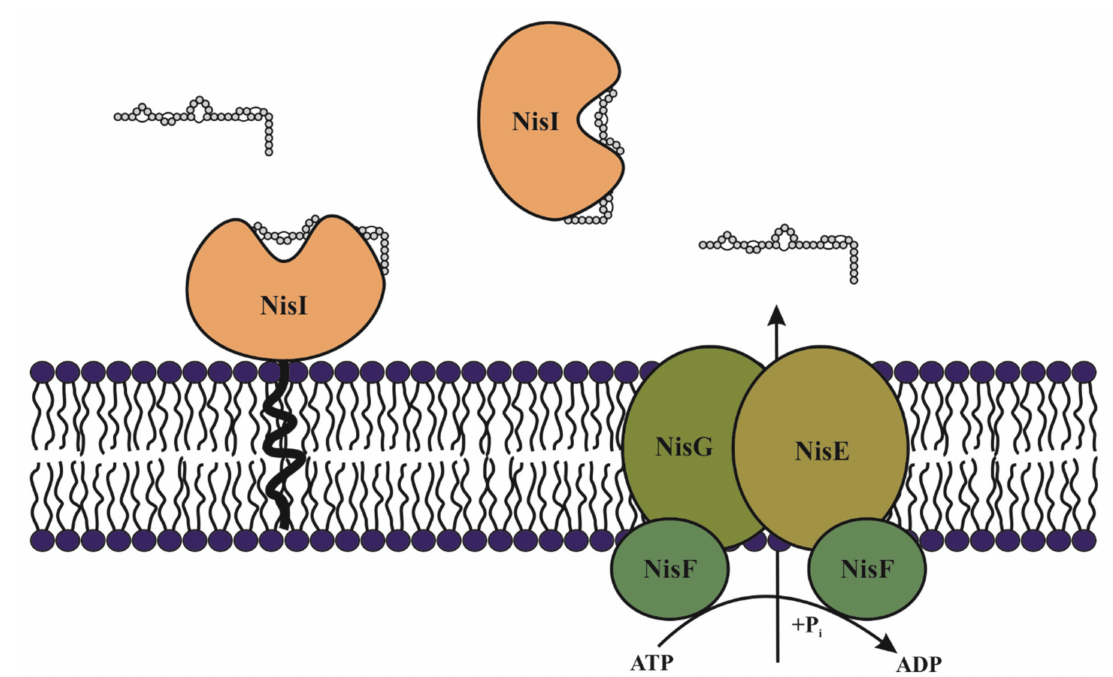
Figure 4. Mechanisms of immunity in the nisin producing L. lactis to protect itself from the action of the nisin. The lipoprotein NisI can be anchored to the membrane or released into the medium, and in both cases, it is able to bind to nisin, inhibiting pore formation. The ABC transporter NisEFG expels nisin from the membrane, thus avoiding pore